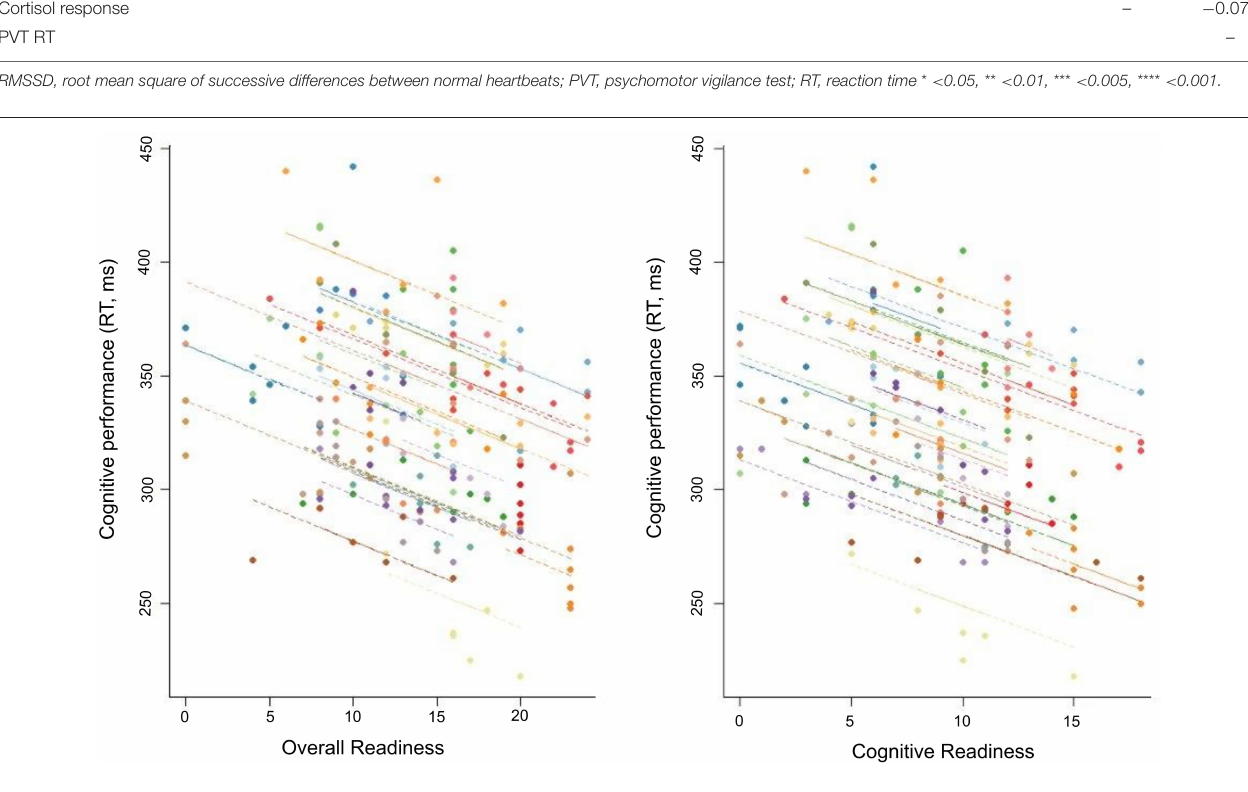
when HRV and cortisol were added, though HRV contributed more to the variance in each model than cortisol ( Table 3